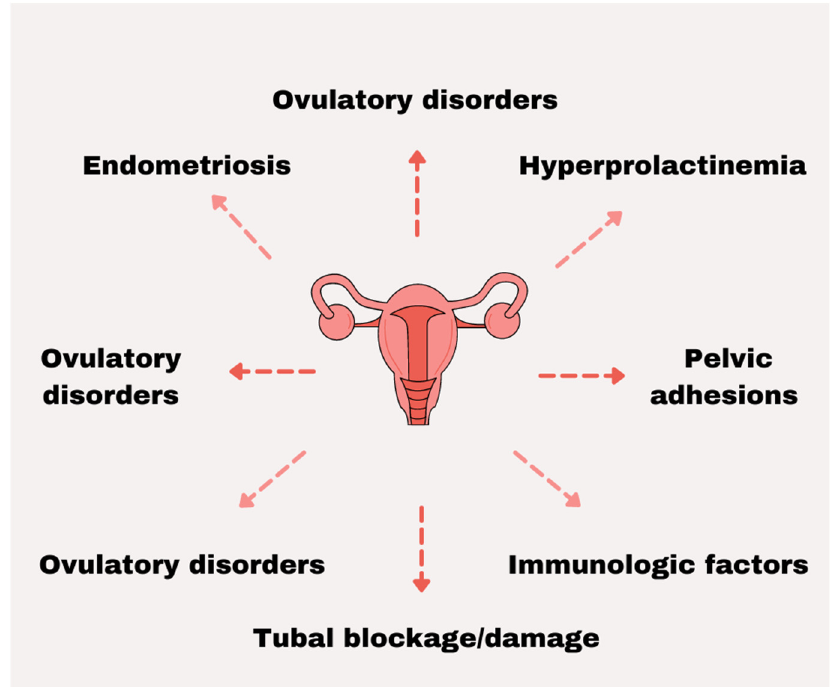
Figure 1. The most prevalent factors associated with female